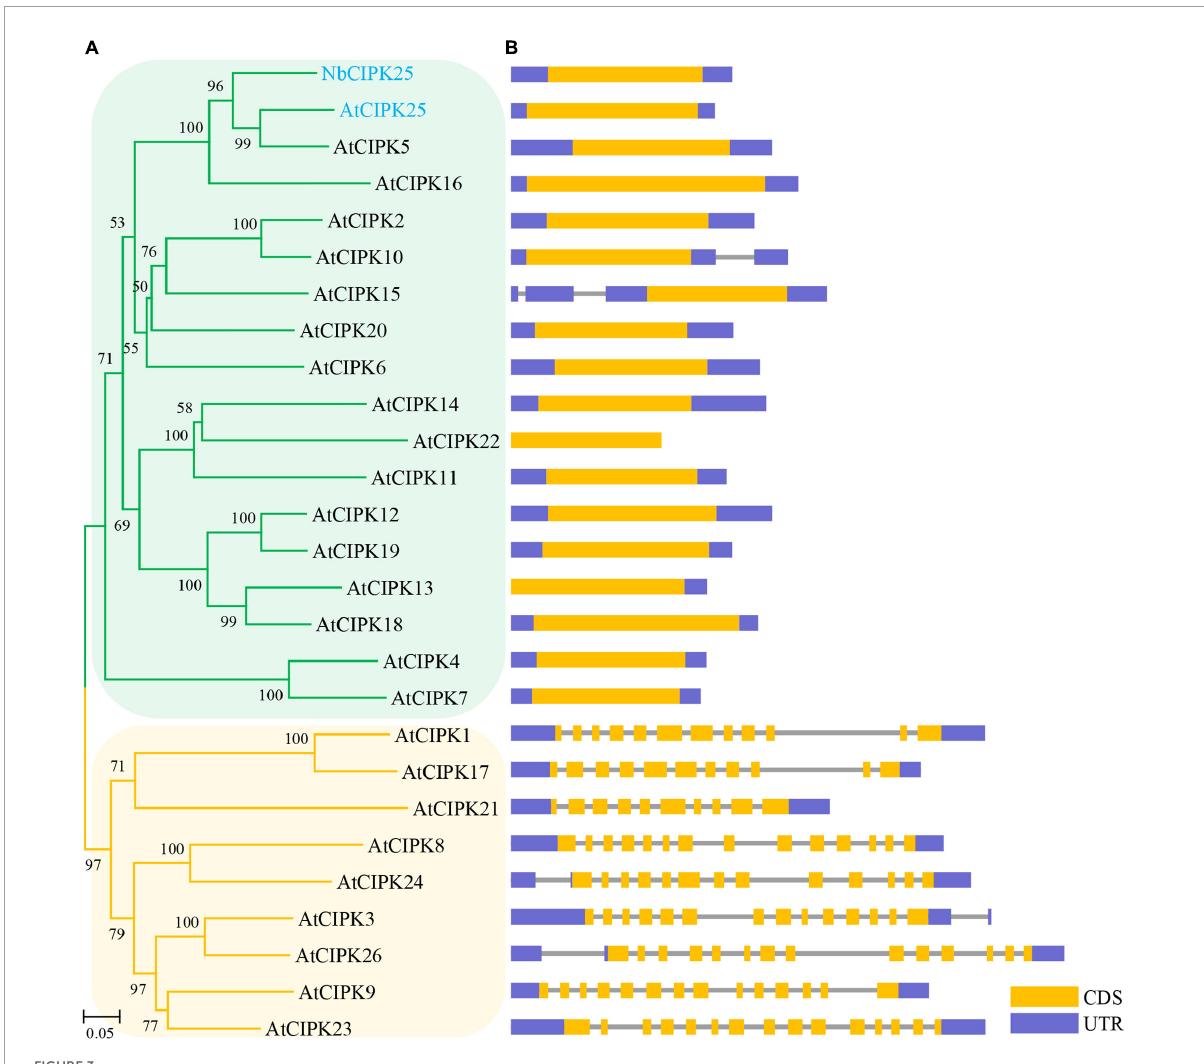
FIGURE3 Evolutionary analysis of NbCIPK25 and Arabidopsis CIPKs. (A) 26 CIPKs from Arabidopsis and NbCIPK25 were used for a phylogenetic study; The genes clustering in the orange branches contain introns in their genomic sequences. The intron-less genes are clustered in the green branches. (B) Architectures of NbCIPK25 and AtCIPK s including their coding sequence (CDS) and untranslated region